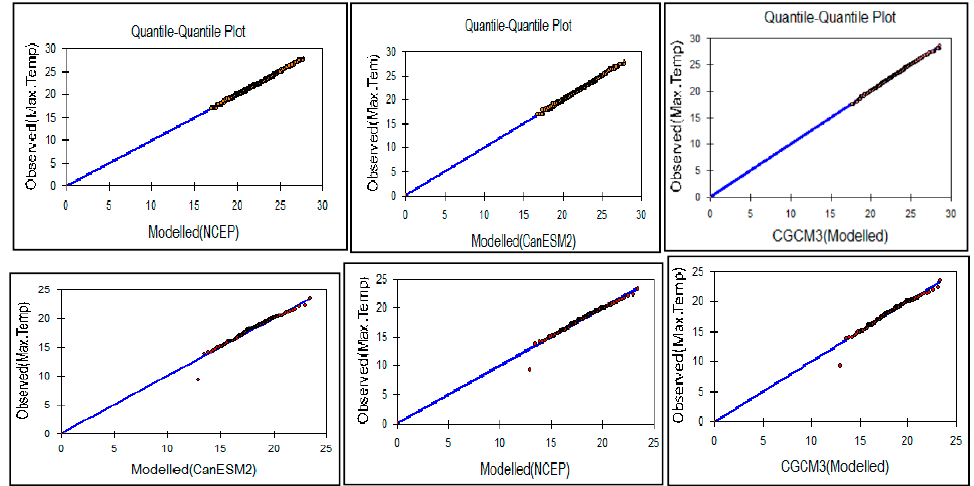
Figure 3. Quantile–quantile (Q–Q) plots of observed versus modeled maximum temperature (°C) at Addis Ababa (upper) and Entoto (bottom) stations .